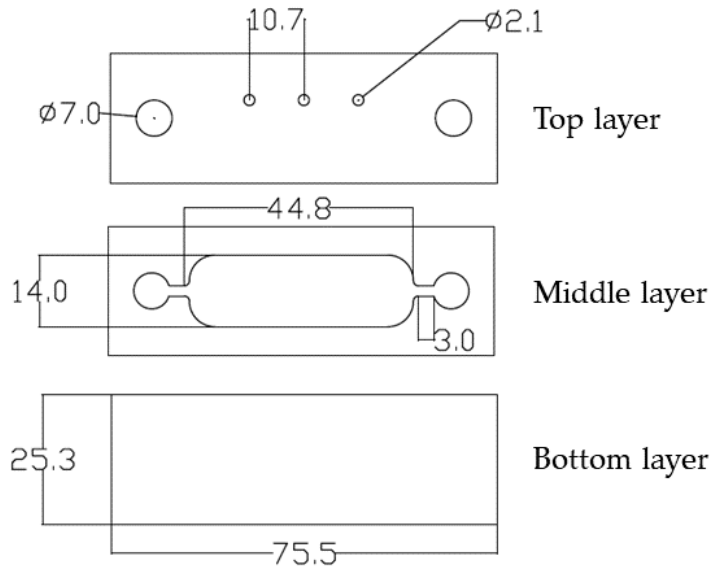
Figure 1. The 2D layer layouts of the microfluidic chip. The top layer contains inlet/outlet holes and three holes for the PreSens sensors. The middle layer contains chamber design, and the bottom layer closes the MF chip.